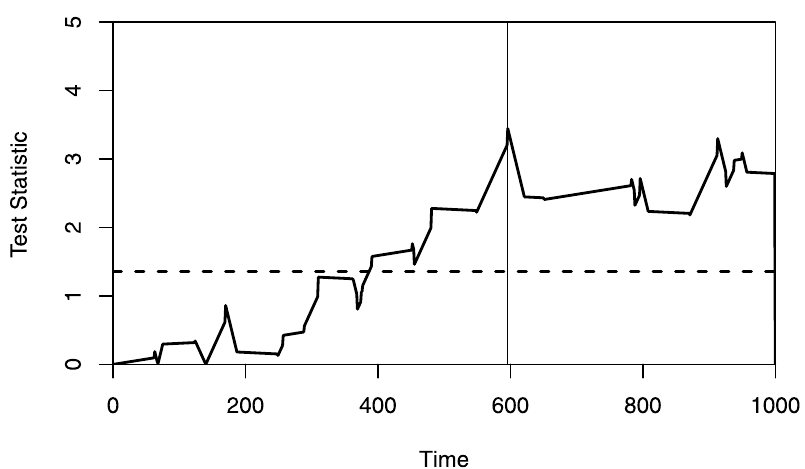
Fig 3. The value of W 1 when testing for α 2 , the critical value at α = 0.05 is 1.35, and the location of change-point is